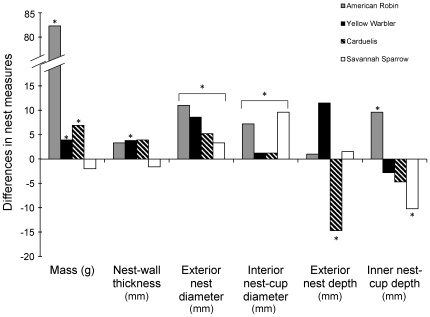
Differences between study sites in six measures of nest morphology.Differences in six measures of nest morphology between northern Manitoba and southeastern Ontario for American Robin (grey), Yellow Warbler (black), Carduelis (hatched), Savannah Sparrow (white). Bars represent the difference in nest morphology between sites (e.g., [nest mass in northern Manitoba]-[nest mass in southeastern Ontario]), such that positive values represent nest measures that are larger in northern Manitoba, and negative values represent nest measures that are larger in southeastern Ontario. Nest mass is recorded in grams, all other nest variables are recorded in millimeters. * denotes a significant difference (P<0.05) between study sites.